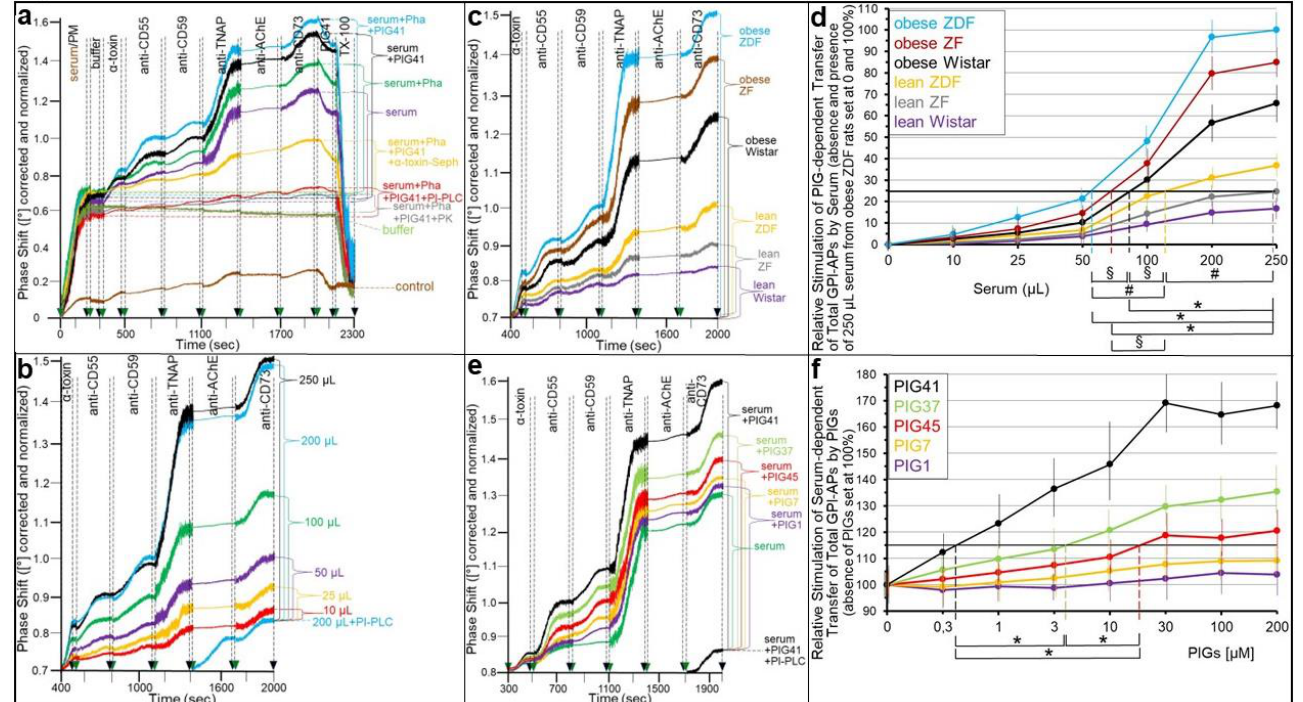
Figure 9. Transfer to ELCs of GPI-APs released from serum GPI-binding proteins of metabolically dysregulated rats by PIGs. ( a – f ) GPI-deficient EL acceptor cells were incubated (1 week, 37 °C, 5 mM glucose, 1 mM Ca 2+ ) in the bottom wells of transwell co- cultures with 200 μL buffer ( a ) or serum ( a , c , e , f , 200 µL; b,d, increasing volumes), which were prepared from obese ZDF rats ( a , b , e , f ) or rats of different metabolic states ( c , d ), then diluted 10-fold with PBS lacking (( a ), as indicated) or containing 2 mM Pha ( a – f ) and thereafter left untreated (( a ), as indicated; b – f ) or incubated with proteinase K (PK), bacterial PI- PLC (PLC), α - toxin coupled to Sepharose beads (α -toxin) ( a ), 30 μM PIG41 ( a – d ) or different PIGs (( e ), 30 µM; f, increasing concentrations). Thereafter, the ELCs were washed thoroughly by rinsing the bottom wells three times with 2 mL each of 20 mM Tris/HCl, 1.5 M NaCl and then two times with 2 mL each of PBS. Subsequently, PMs were prepared from the ELCs, coupled to chips by ionic/covalent capture (0 – 200 s), as described in Section 4, and then analyzed for expression of GPI- APs by SAW sensing. As a control, 200 μL serum from obese ZDF rats instead of PMs were injected into the chips (0 – 200 s ) at a flow rate of 60 μL/min ( ( a ) only, brown curve). After washing of the channels with buffer (200 – 300 s ) at a flow rate of 200 μL/min, α -toxin (30 μg/mL, 30 0 – 500 s), anti-CD55 (500 – 800 s), CD59 (800 – 1100 s), TNAP (1100 – 1400 s), AChE (1400 – 1700 s) and CD73 (1700 – 1950 s) antibodies (at the dilutions given in Supplementary Materials, Materials) were injected successively at a flow rate of 15 μL/min, followed by 30 μM PIG41 (195 0 – 2150 s, shown only for ( a )) and then 0.2% TX-100 (2150 – 2300 s, shown only for ( a )) at a flow rate of 45 μL/min. Measured phase shifts were correc ted and normalized as described for Figure 1 ( a ) or by subtraction of the control (see ( a ), serum instead of PM, brown curve) values ( b , c , e ). ( a , c ) Phase shift Δ between the start of the α -toxin (300 s) and termination of the anti-CD73 antibody (1950 s) injection indicated by the horizontal, hatched lines (( a ) only) are given by brackets. ( b , e ) Brackets indicate the difference between the total phase shift induced by α -toxin and all antibodies for each incubation condition and a control phase shift induced by pretreatment of 200 μL serum with PIG41 and bacterial PI-PLC (blue and black curves). ( d , f ) The experiments (see ( c , e ), respectively) were repeated (four or six incubations and distinct chips with four channels per incubation) using increasing volumes of untreated serum from rats of different metabolic states ( d ) or increasing concentrations of different PIGs ( f ). The relative stimulation of PIG- (( d ) , 30 μM PIG41) and serum - (( f ) , 250 μL, obese ZDF rats) dependent transfer of total GPI-APs, as r eflected in the α -toxin- and antibody-induced phase shifts, are calculated with the absence and presence of 250 µL serum from obese ZDF rats set at 0 and 100%, respectively, ( d ) or absence of PIGs set at 100% ( f ). Significant differences between the volumes effective in the 25% stimulation (EV 25 , ( d )) or concentrations effective in 15% stimulation (EC 15 , ( f )) of transfer (horizontal black lines) by the different sera ( d ) and PIGs ( f ), respectively, are indicated (vertical, colored, and hatched lines) (means ± SD; * p ≤ 0.01, # p ≤ 0.02, § p ≤ 0.05).